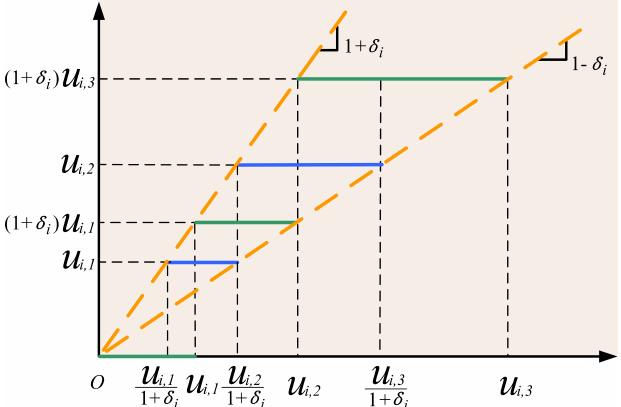
Figure 1. Quantization for networked